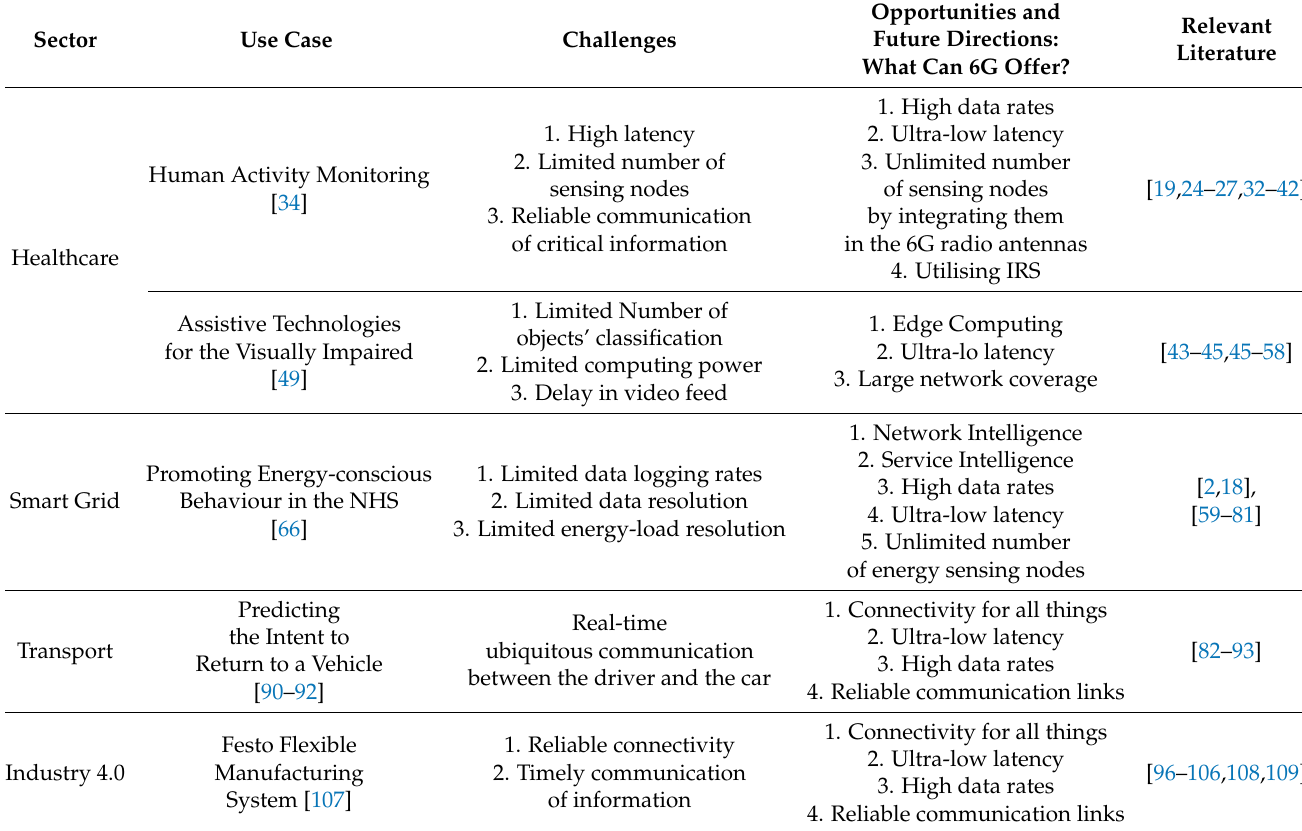
Table 1. A collective summary of the challenges, opportunities, and future directions of the presented use cases, in the context of 6G.